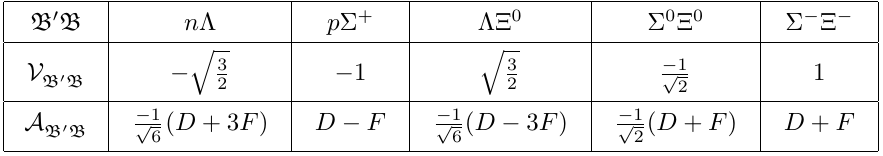
Table 1 . Values of V B 0 B and A B 0 B in eq. (2.1) for BB 0 = (cid:3) n; (cid:6) + p; (cid:4) 0 (cid:3) ; (cid:4) 0 (cid:6) 0 ; (cid:4) (cid:0) (cid:6) (cid:0) . The parameters D and F are from the lowest-order chiral